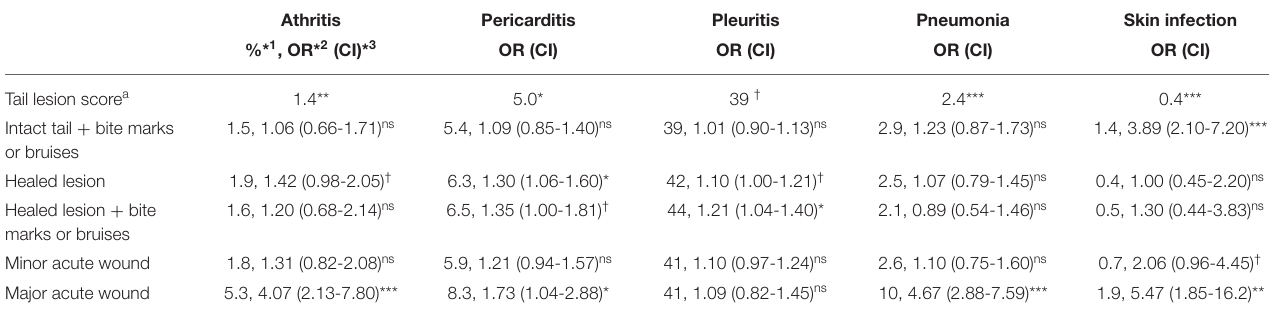
TABLE 5B | Results from logistic regressions on the association between tail lesion score, when the tail was at least 24cm ( n = 11756) and arthritis, pericarditis, pleuritis, pneumonia, and skin infection recorded at meat inspection. Athritis